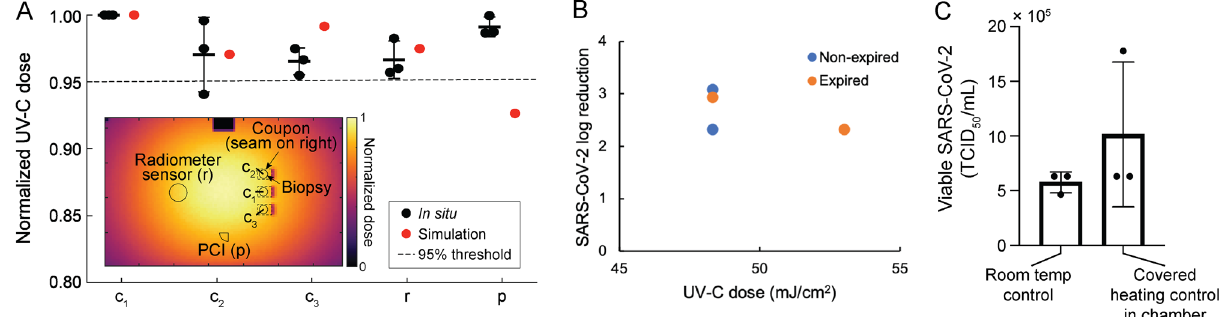
Figure 2. Experimental design and controls for SARS-CoV-2 dose response measurement on N95 coupons. ( A ) Using the optical model and validating in situ, five locations within the decontamination chamber receiving similar UV-C doses (< 5% variation between mean in-situ dose measurements at each location) were identified. To inform biopsy location, the optical model also assessed the impact of each coupon seam (Figure S17; modeled as 15 mm wide × 2.5 mm tall × 1 mm thick absorbing rectangular volumes at the right-hand side of each coupon) on UV-C distribution. In-situ measurements were made using PCIs to simultaneously measure dose received at the PCI and 3 coupon locations while simultaneously recording irradiance with the radiometer. Mean and standard deviation are indicated for the in-situ measurements. ( B ) SARS-CoV-2 inactivation did not depend on the expiration status of 3M 1860 N95 coupons used in this study (N = 2 replicates/condition). ( C ) Comparison of SARS-CoV-2 survival on N95 coupons at room temperature and within the chamber shielded from UV-C during illumination demonstrates that chamber heating does not impact inactivation. p > 0.9999, Wilcoxon matched-pairs signed rank 2-tailed test. Bars denote mean of N = 3 measurements per condition; whiskers denote standard deviation; points denote individual